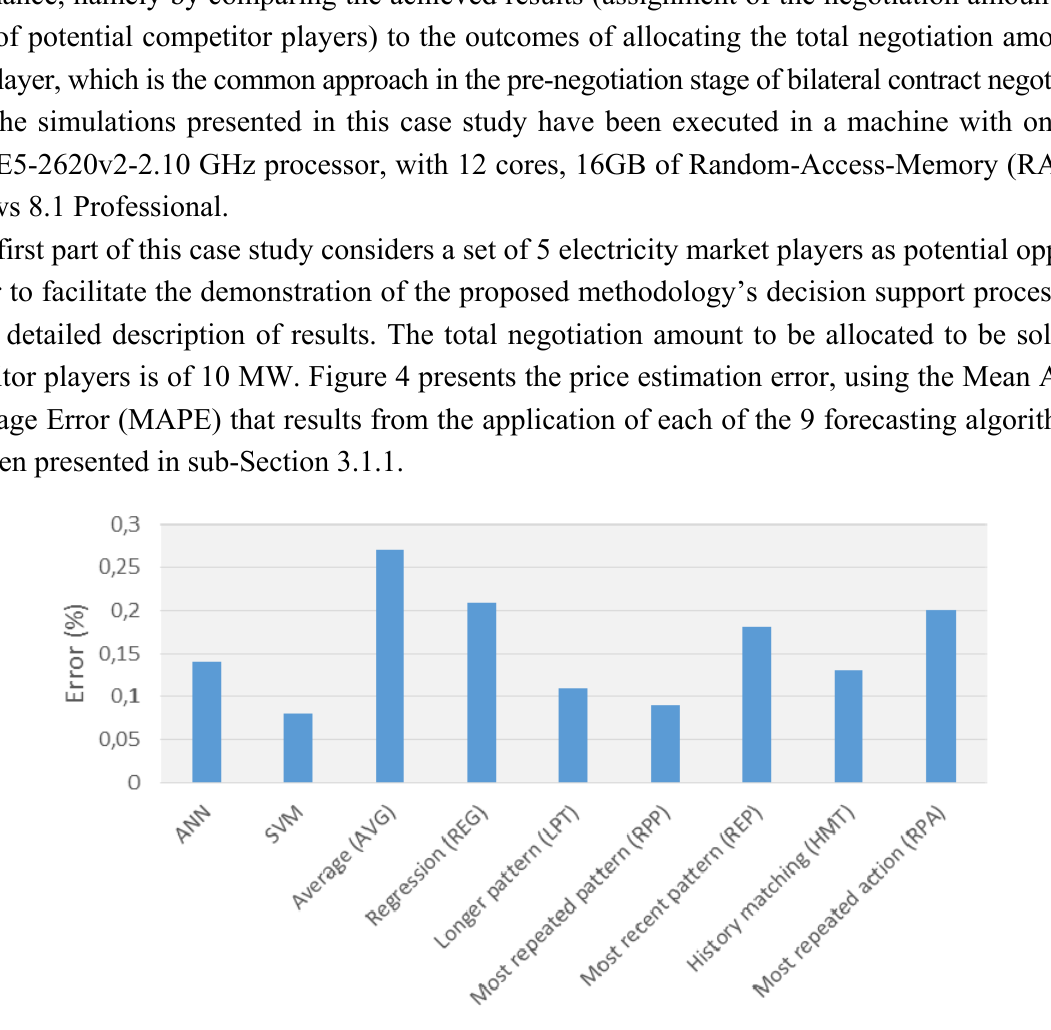
Figure 4. Mean Absolute Percentage Error (MAPE) estimation error using each of the considered forecasting